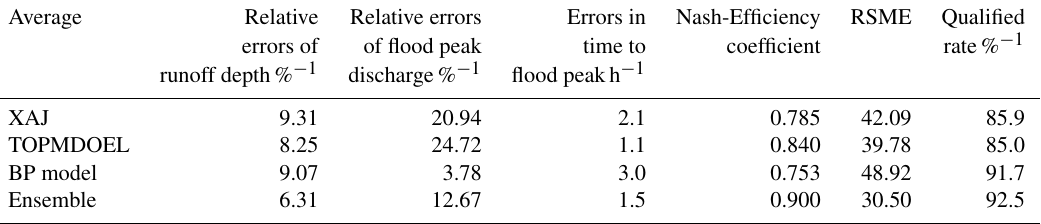
Table 4. Weight coefficients assigned to the three models based on the entropy method. Flood number 810623 XAJ TOPMODEL Flood number TOPMODEL Flood number XAJ 0.267 TOPMODEL 0.482